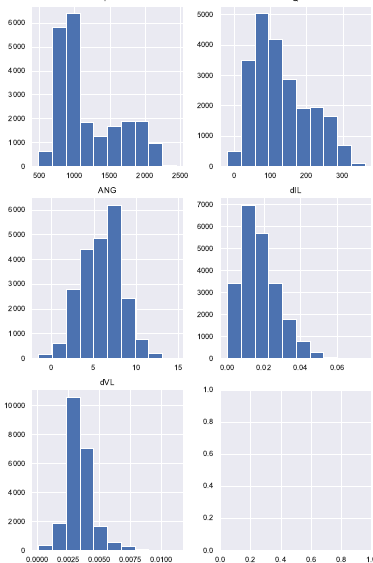
Figure 20. Histograms of the extended variables in Scenario